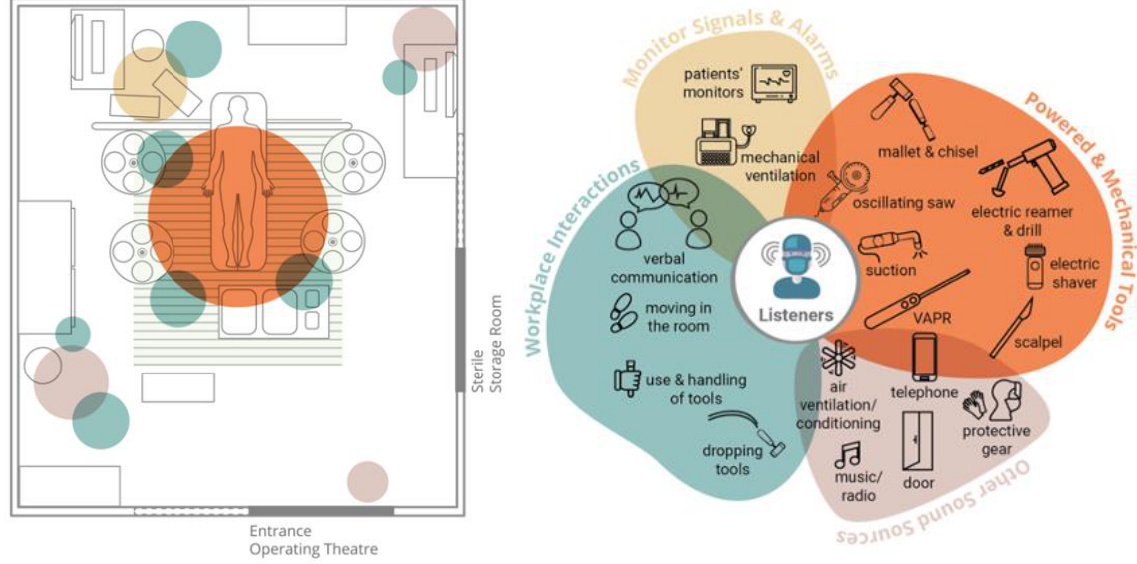
Figure 7. The sound map of an OR with the acoustic impact of sound events.